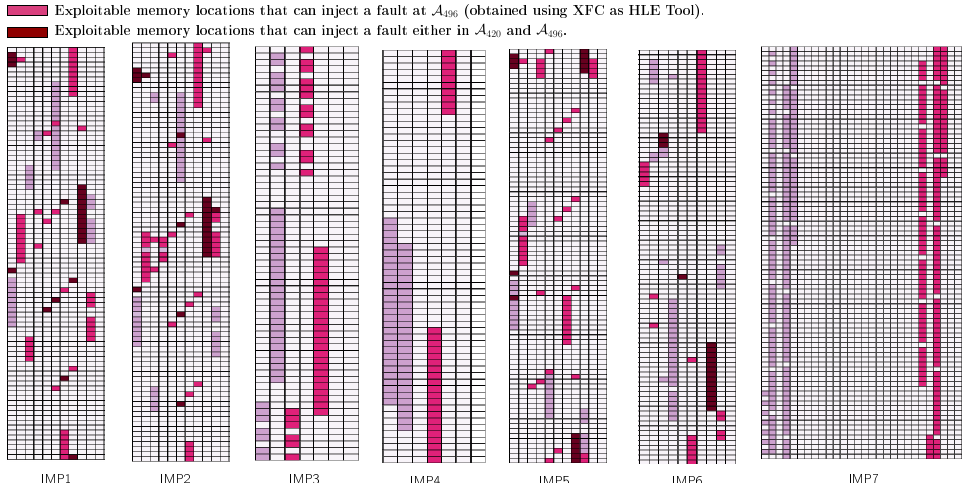
Figure 11: Fault Evaluation output for different implementations of AES given in Table 2 for fault injected at locations A 496 and A 420 . The fault evaluation for A 496 was done using he HLE tool XFC [KRH17], while the fault evaluation for A 420 was done using the HLE tool ExpFault [SMD18]. Each cell denotes an instruction in the IR. Starting from the top left corner, instructions are represented column wise from top to bottom. The last instruction is in the bottom right corner. The colored cells denote the exploitable instructions based on HLE tool XFC and